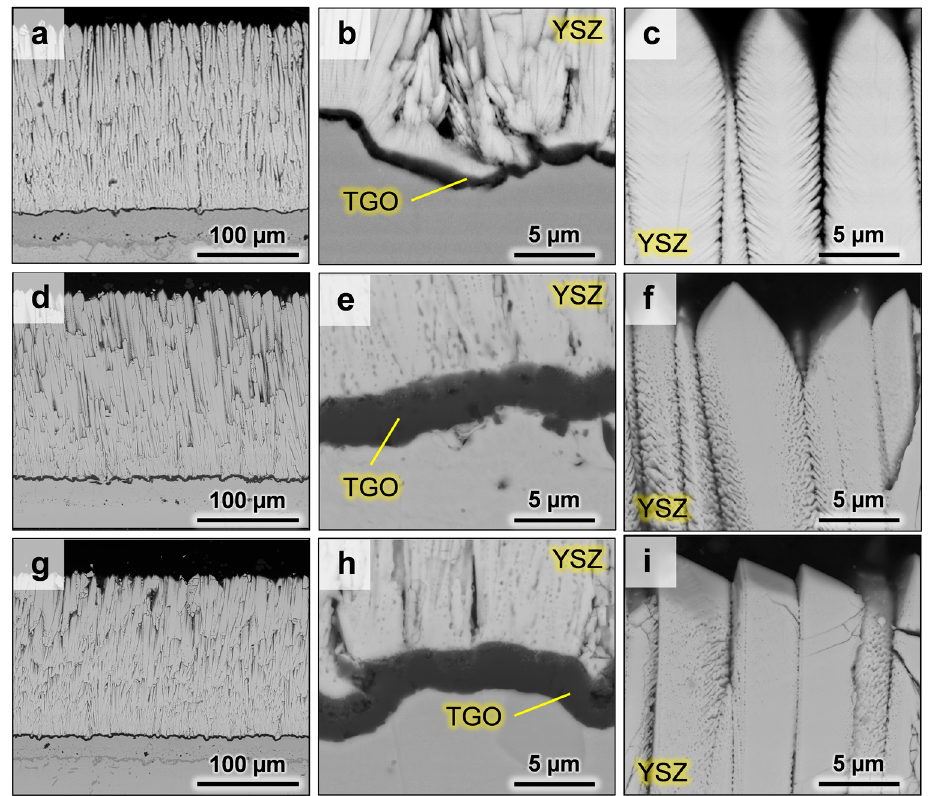
Figure 1. SEM micrographs of the electron-beam physical vapour deposition (EB-PVD) standard yttria-stabilised zirconia (8YSZ) coatings in the as-deposited conditions with ( a – c ) (similar for both standard and Er 2 O 3 -doped coatings) and after ageing in air at 1250 °C for 1 h with ( d – f ) for the standard 8YSZ coating and ( g – i ) for the ErYSZ coating.